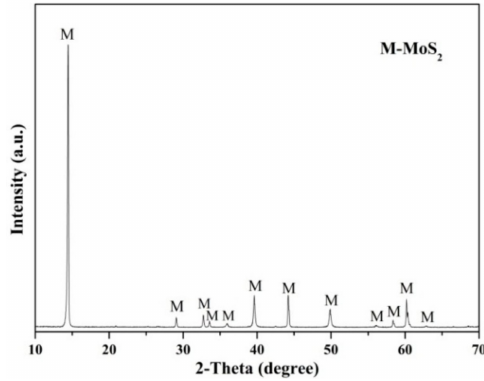
Figure 1. X-ray Diffraction pattern (XRD) of MoS 2.